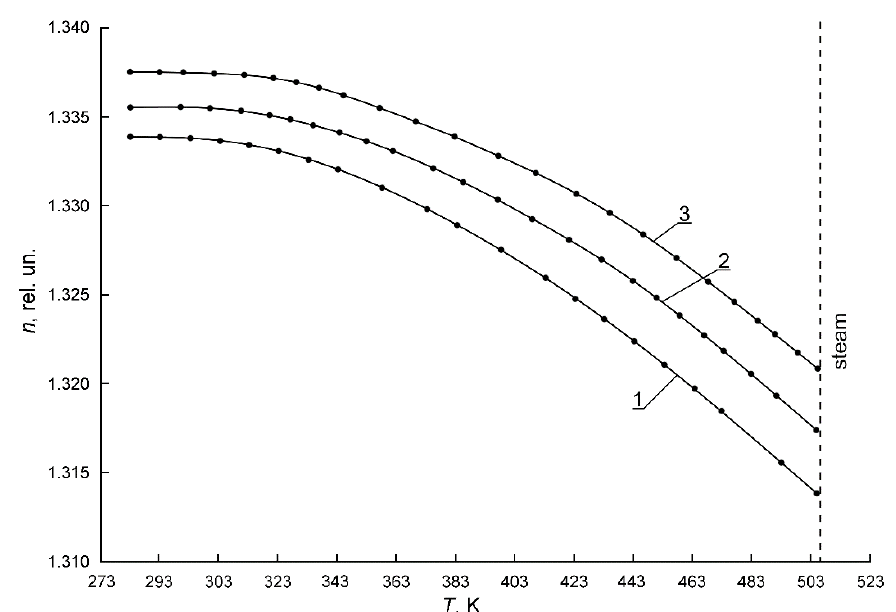
Figure 6. The dependence of the refractive index n of the feed water on the temperature T . Graphs (1 – 3) correspond to the following: absence of impurities in water, presence of iron oxides and carbon steel in water, presence of technical oils in water.